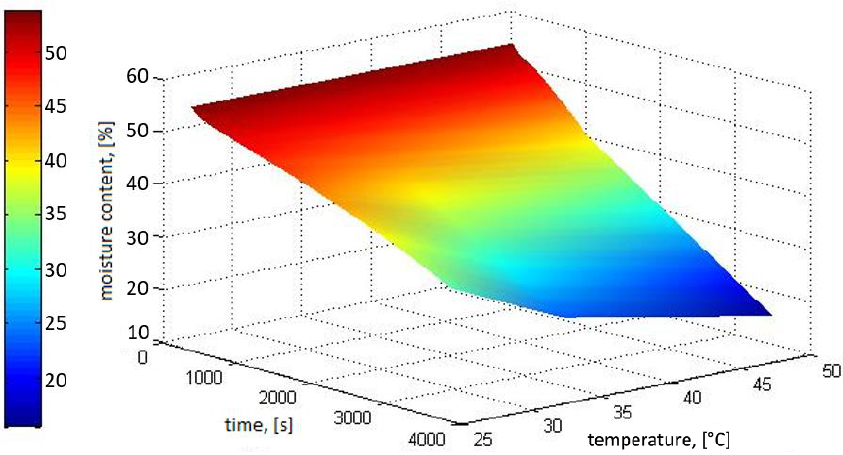
Figure 14. Influence of chamber geometry on the coal drying process. The grain size was 0–8 mm, temperature 27 °C, Turów coal.